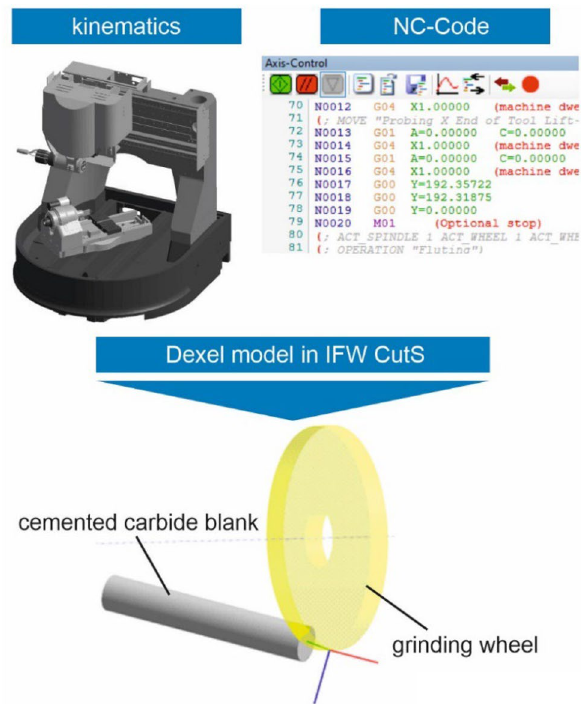
Fig. 1 Procedure of the creation of the simulation model